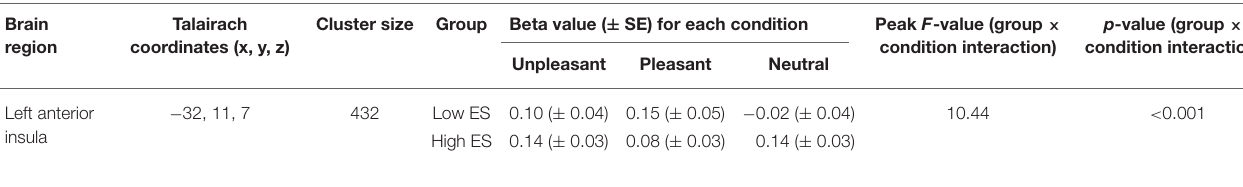
p -value (group × condition interaction) condition interaction)